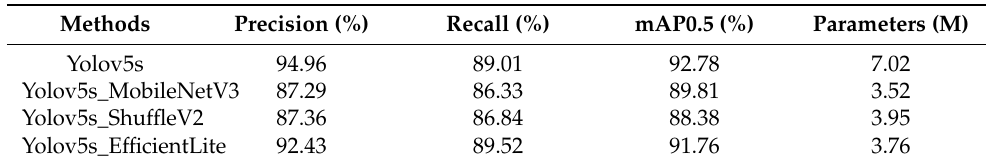
Table 1. Comparison results of lightweight models.